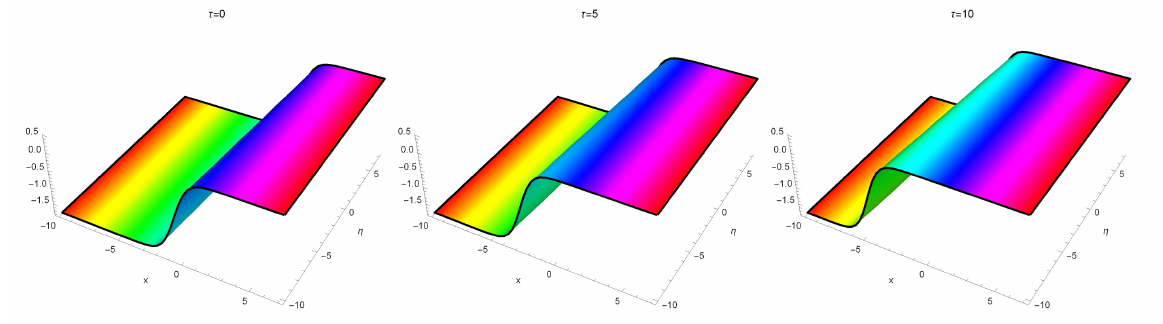
Fig. 5. The solution w 5 ( x , y , t ) for κ = 2, ω = 0.8, µ 1 = 0.65, µ 2 = 10, µ 3 = 0.4; α 0 = 0.5.